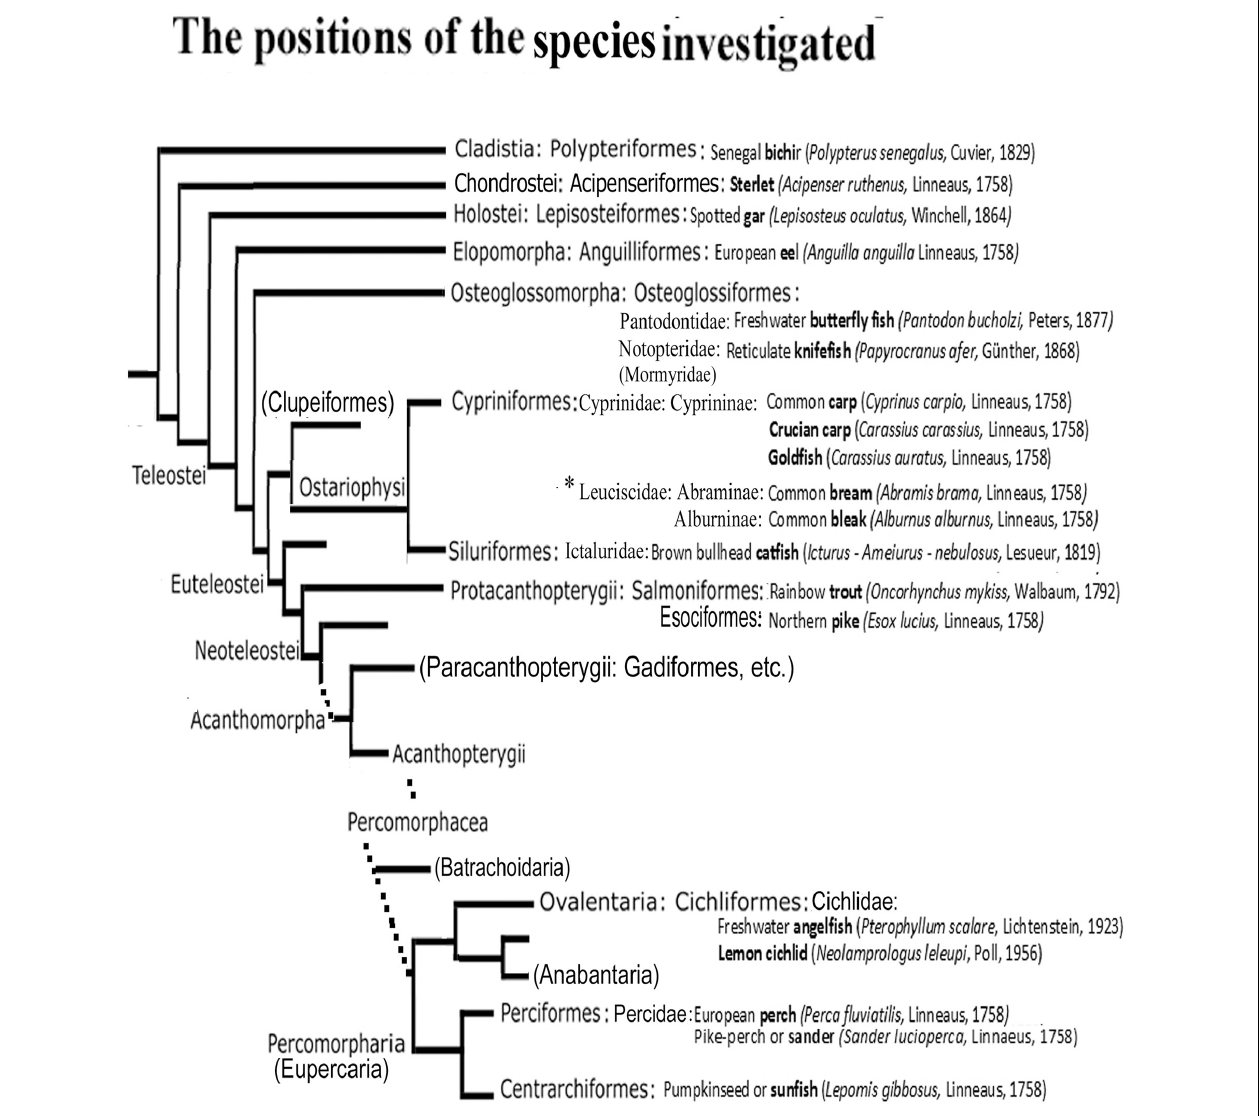
FIGURE 1 | The positions of the species studied in the phylogenetic tree. After Betancur-R et al. (2013, 2017), simplified. Only the taxa relevant for understanding the study are introduced. The short names in bold are used throughout the text and Legends. Families and subfamilies are only given when more than one are represented of the same ordo in the study including the Appendix 1. Ordos named in bracket have no representatives investigated here, but do have in the Appendix 1, or help general orientation. Dotted lines: the several intermediate branchings are not demonstrated. The main differences from other taxonomies are discussed at the end of Discussion. ∗ A recent study (Schönhut et al., 2018) separated Leuciscinae from Cyprinidae as Leuciscidae.